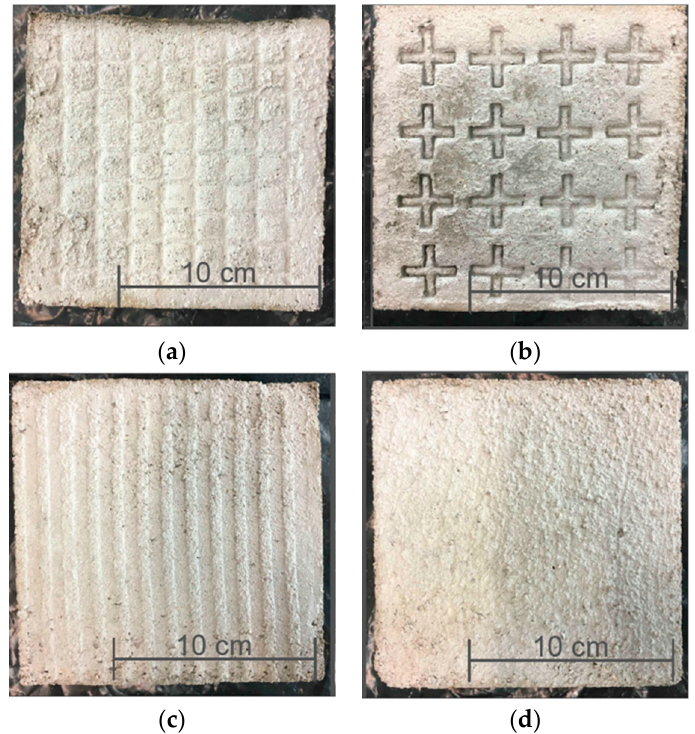
Figure 5. Exemplary optical views of the surfaces of the concrete substrates after 28 days of maturation: ( a ) grooved; ( b ) imprinted; ( c ) patch grabbed; ( d ) brushed.